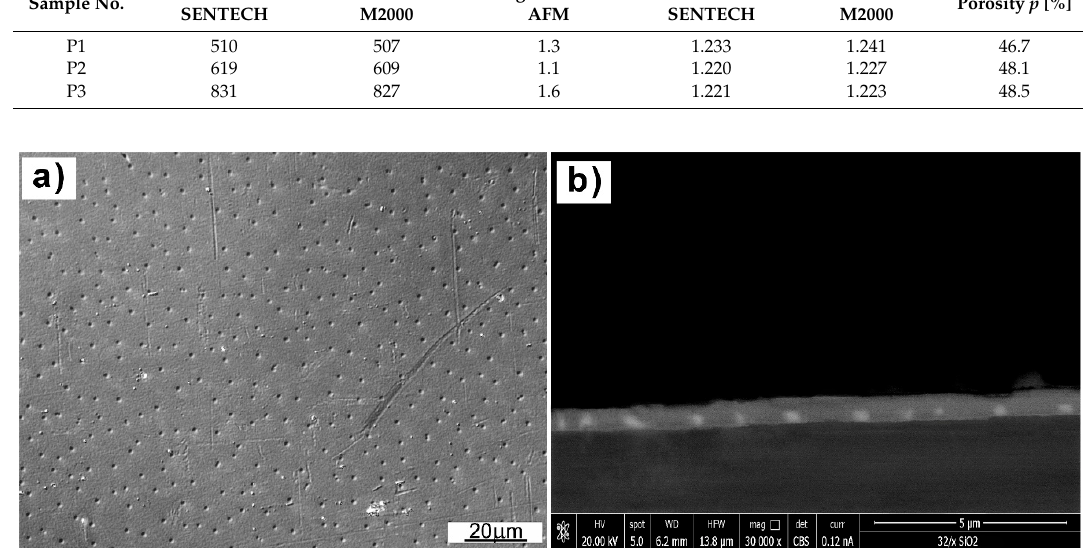
Figure 2. SEM micrographs of SiO 2 films: ( a ) Surface of porous silica film, ( b ) film profile of sol-gel- obtained porous SiO 2 film on Si substrate (sample P1).